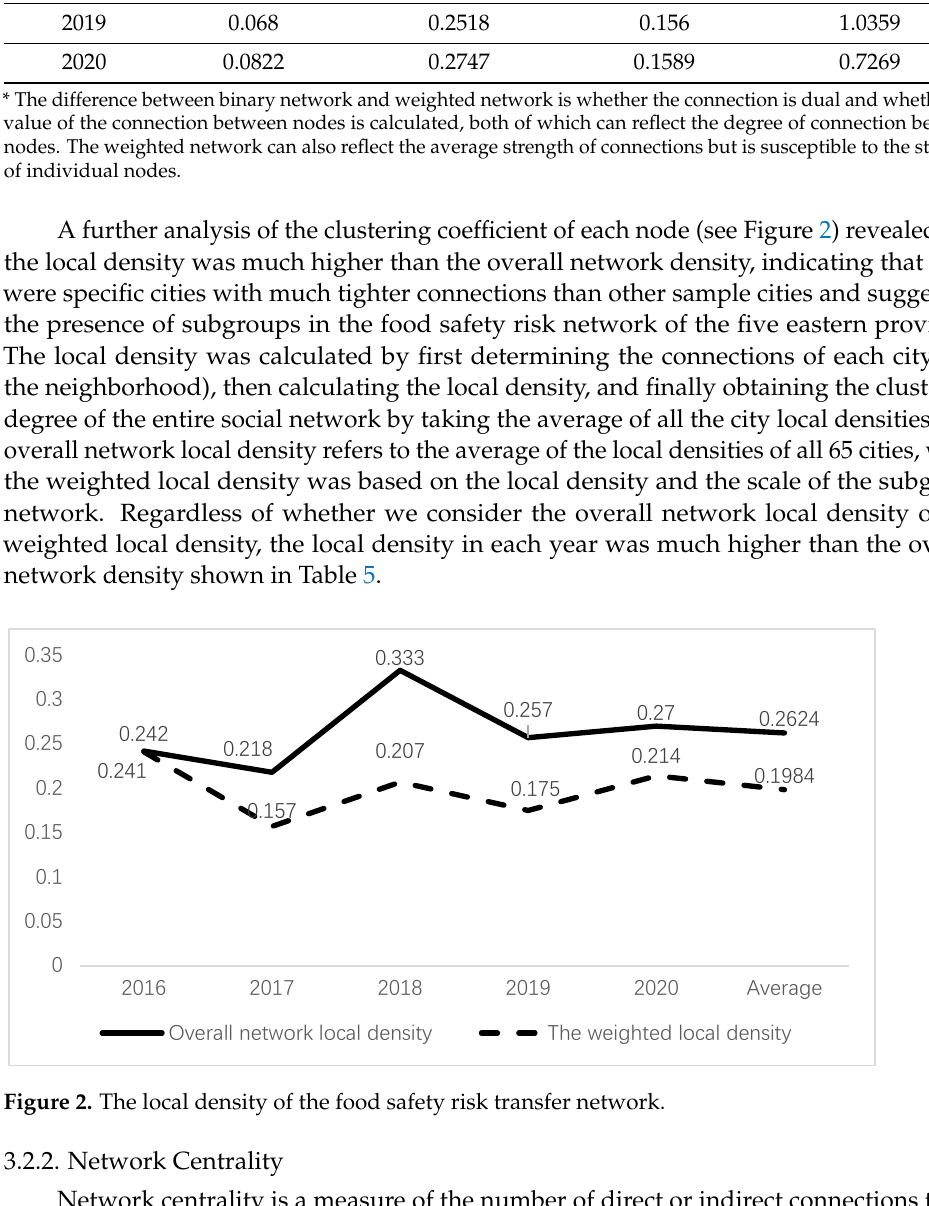
Table 5. The food safety risk transfer network density.